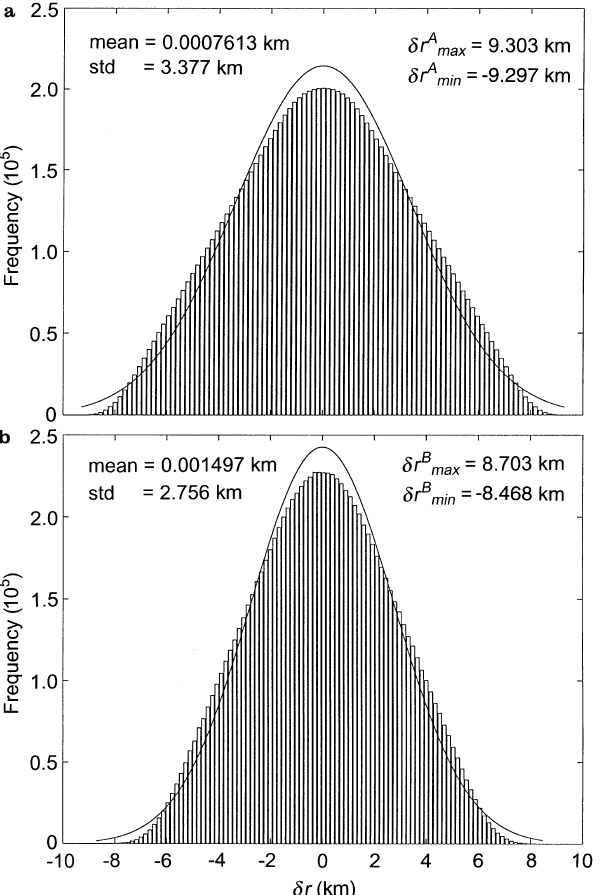
Fig. 2a,b. Same as Fig. 1, but for r 1 (cid:136) 6 R